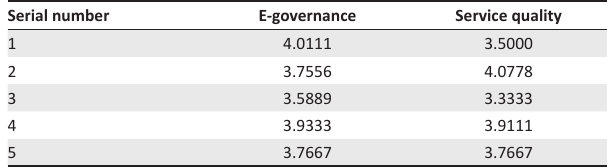
Table 5 measured e-governance and service quality using